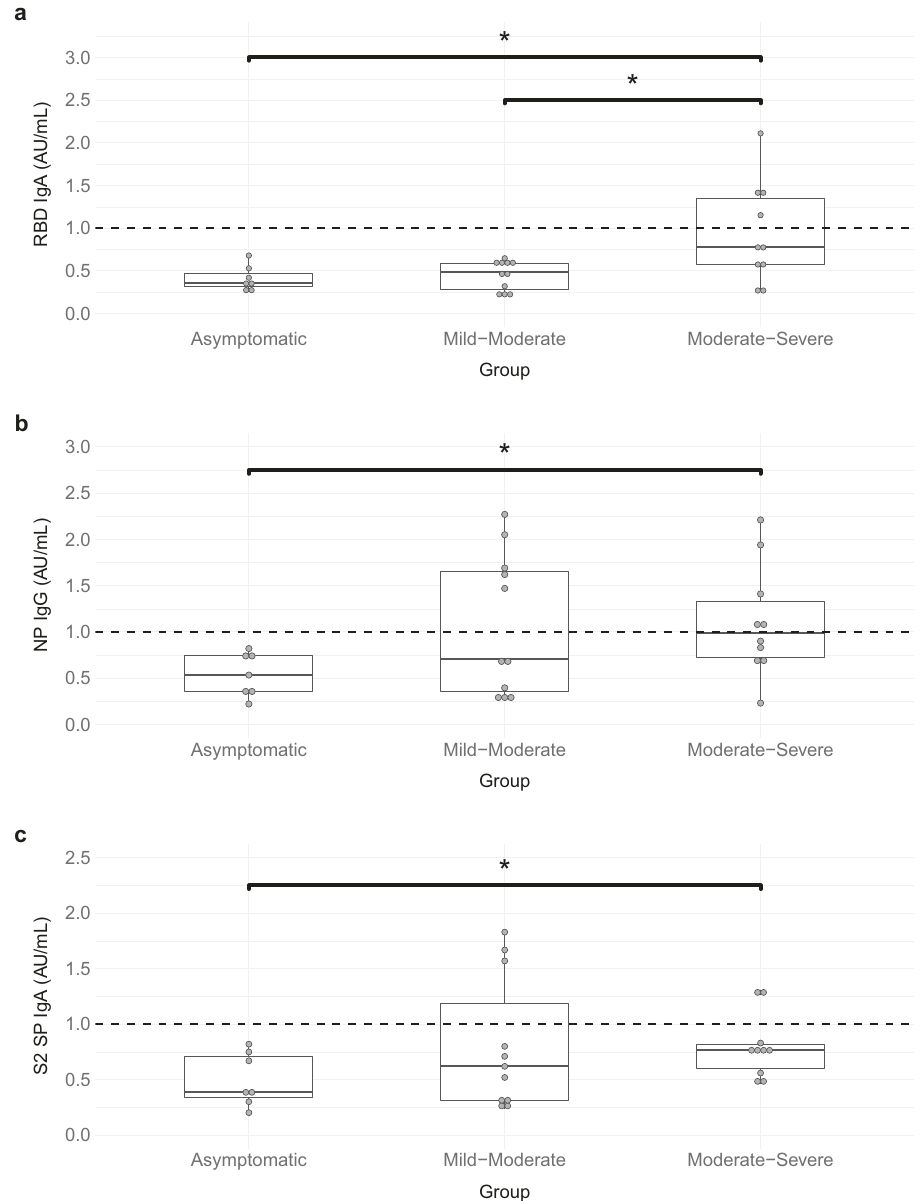
Fig. 1 IgA antibody titers against receptor-binding domain (RBD) and spike 2 glycoprotein (S2 SP) and IgG antibody titers against nucleoprotein (NP) plotted against symptom severity in COVID-19-positive participants. Comparison of a IgA antibody titers against RBD, b IgG antibody titers against nucleoprotein, and c IgA antibody titers against S2 SP in COVID-19-positive participants with no symptoms (asymptomatic, n = 7), mild-moderate symptom severity ( n = 11), and moderate-severe symptom severity ( n = 10). Boxplots represent the minimum, maximum, median, fi rst quartile and third quartile in the data set. The cut-off value for the serological test ( ≥ 1) is shown as a black dashed line for reference. IgA antibody titers against RBD were analyzed using one-way ANOVA and Tukey post hoc tests were used for multiple comparisons. IgA RBD titers were signi fi cantly higher in participants with moderate-severe symptoms compared to participants with mild-moderate symptoms ( p = 0.02) and asymptomatic participants ( p = 0.02). IgA antibody titers against S2 SP and IgG antibody titers against nucleoprotein were analyzed using two-tailed Independent Samples T-tests. IgG NP and IgA S2 SP titers were signi fi cantly elevated in participants with moderate-severe symptoms compared to those who were asymptomatic (IgG NP: p = 0.03; IgA S2 SP: p = 0.04). * indicates p < average IgG antibody titers against all antigens showed a trend IgG, or IgM antibody positivity and the presence or absence of towards being greater in COVID-19-positive symptomatic par- symptoms. We found that a larger number of asymptomatic ticipants (mean(SE) = 1.04 ± 0.11) than COVID-19-positive COVID-19-positive participants had at least one positive IgM asymptomatic participants (mean(SE) = 0.64 ± 0.10), ( t (26) = antigen compared to the number with at least one positive IgG − 2.00, p = 0.06). These data suggest that asymptomatic and antigen (Fisher ’ s Exact test, p = 0.05). Collectively, the above fi ndings suggest that COVID-19-positive symptomatic partici- symptomatic COVID-19-positive participants may experience different immune responses to SARS-CoV-2 infection. We uti- pants exhibited a greater IgG immune response and that lized a Fisher ’ s Exact Test to explore associations between IgA, asymptomatic participants had a greater IgM response.